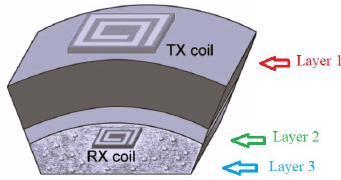
Figure 23. Exposure scenario with the implanted Tx and Rx